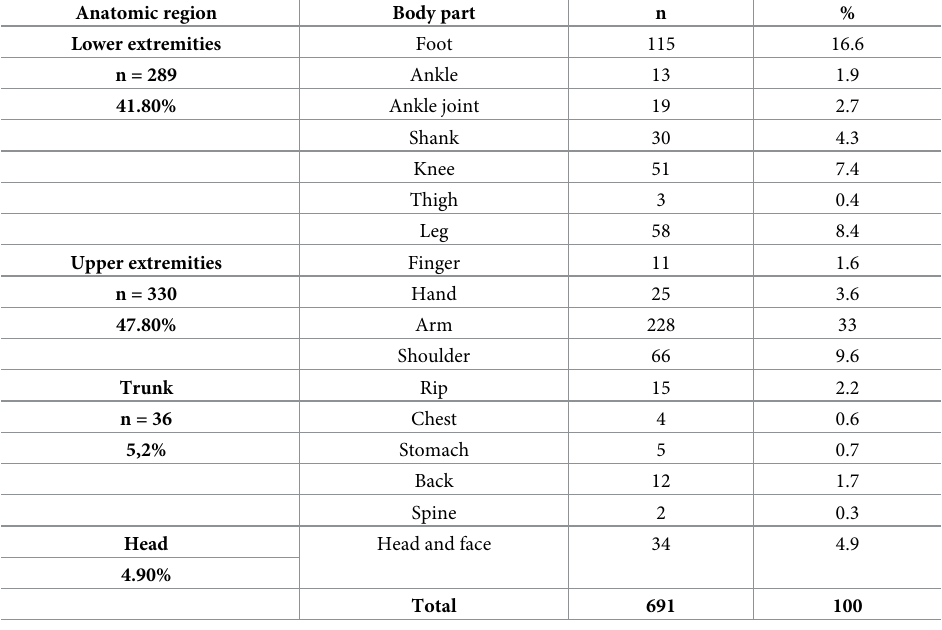
Table 2. Localization of injuries from 482 (35.8%) emergency cases attributed to anatomical location (multiple choices were possible).